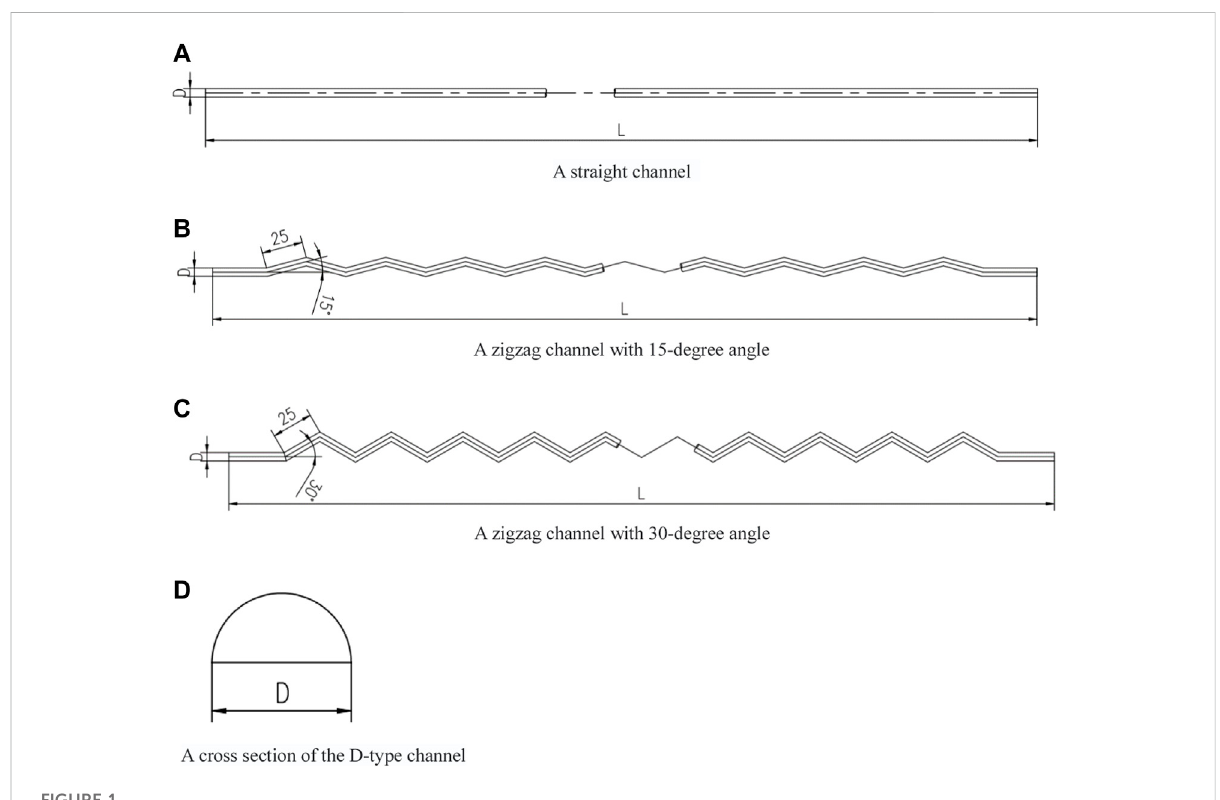
FIGURE 1 Geometry of the D-type channel.